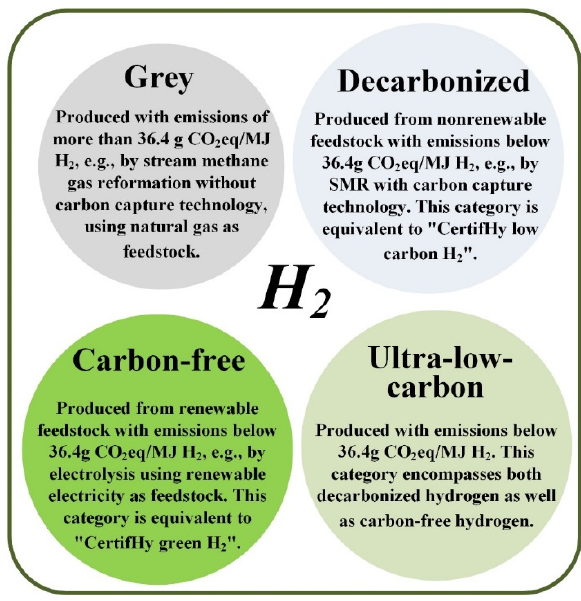
Figure 4. Hydrogen classification by CertifHy.